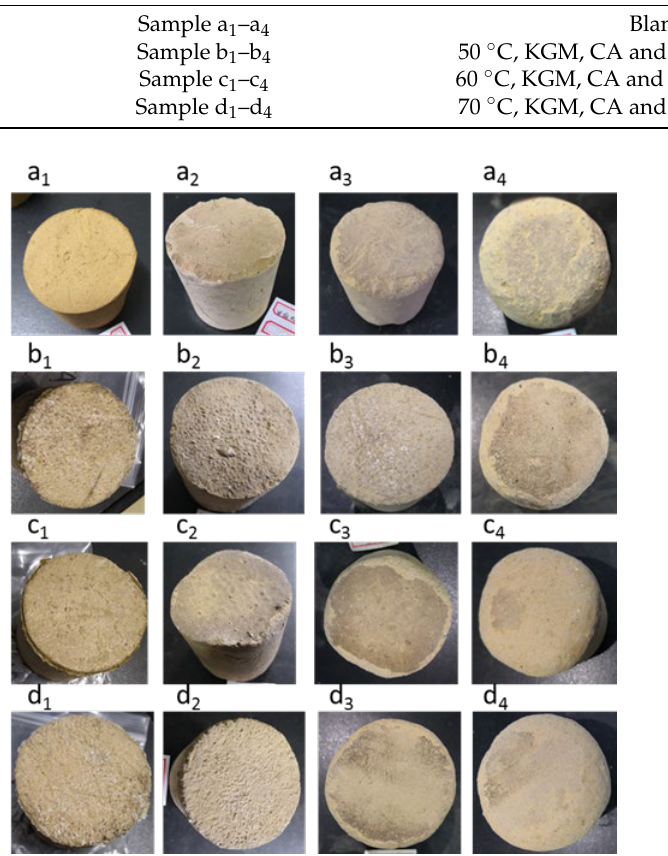
Figure 6. Wear condition of consolidated soil column samples. ( a1 – a4 ) was the blank control group; ( a1 , b1 , c1 , d1 ) formed the control group without any oscillation test; The preparation conditions of ( b1 – b4 ) spraying KGM/CA/PVA ternary blend adhesive were 50 °C, the contents of KGM, CA and PVA are 4.5%, 4%, and 4%, respectively, the pH value is 4.5; The preparation conditions of ( c1 – c4 ) spraying KGM/CA/PVA ternary blend adhesive were 60 °C, the contents of KGM, CA and PVA are 4.5%, 4%, and 3%, respectively, the pH value is 4.5; The preparation conditions of ( d1 – d4 ) spraying KGM/CA/PVA ternary blend adhesive were 70 °C, the contents of KGM, CA and PVA were 4.5%, 3%, and 4% respectively, the pH value was 4.5.